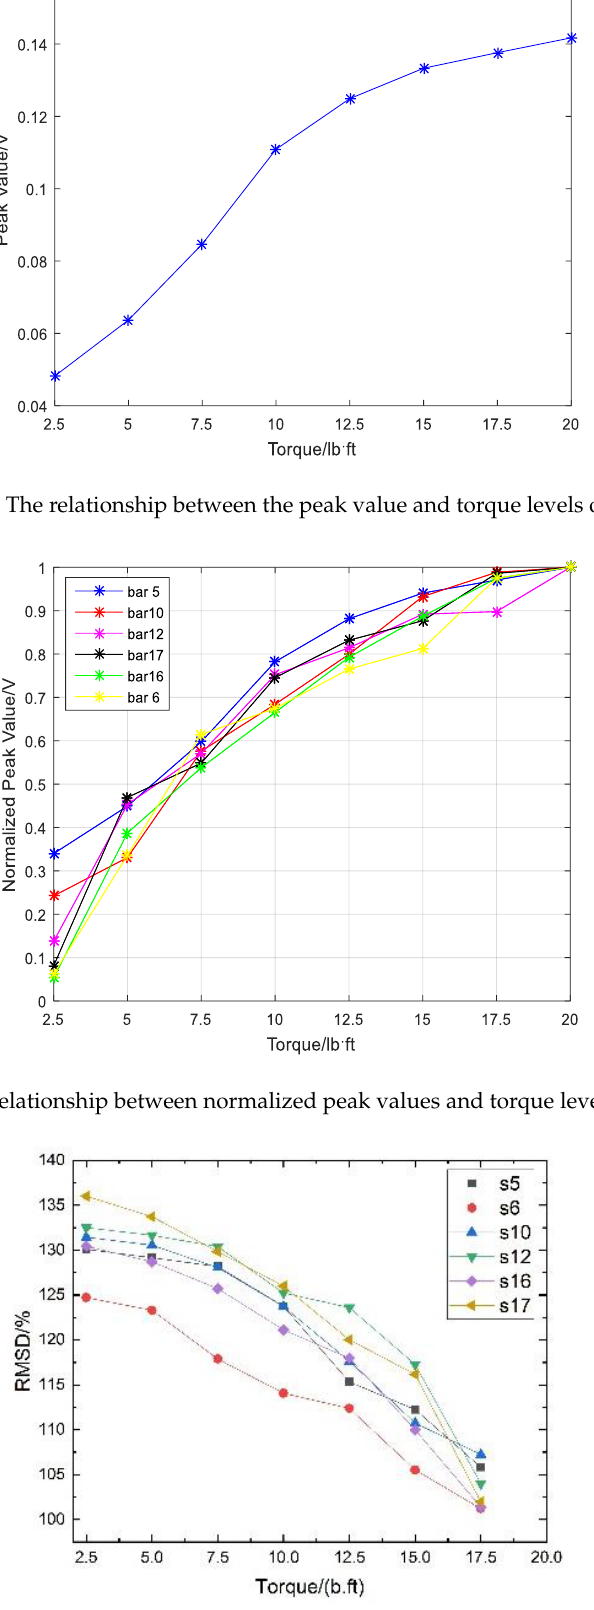
Figure 15. The relationship between the RMSD value and torque levels.